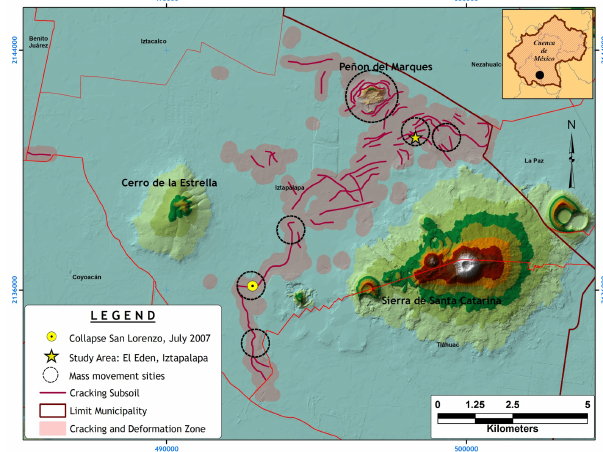
Figure 2. Detailed mapping of fracturing in Iztapalapa (red lines). The Santa Catarina Range is located to the south-eastern sector of Iztapalapa and the Peñon del Marques volcano is located to the north-east. Black circles correspond to the six indentified mass